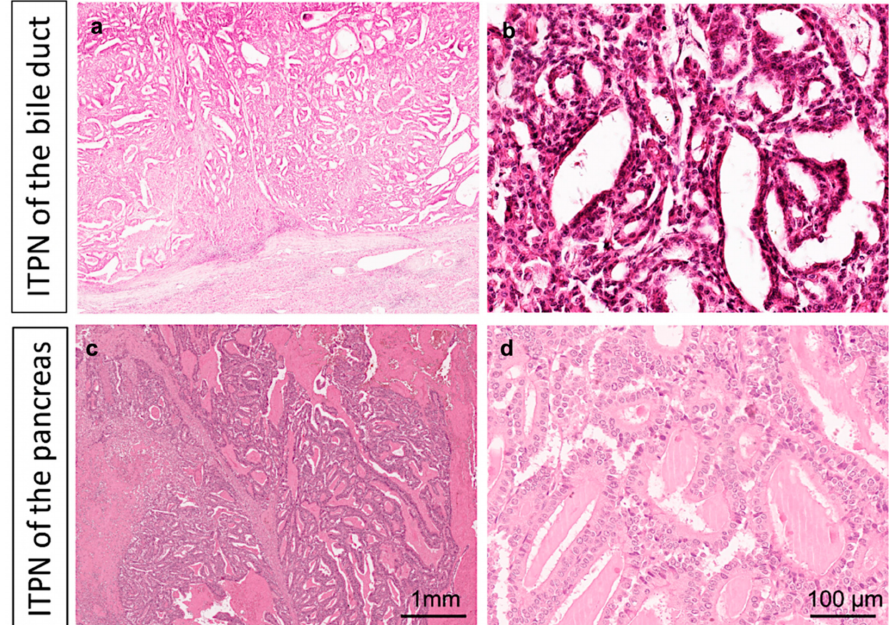
Figure 1. Histopathological hallmarks of intraductal tubulopapillary neoplasms (ITPNs). ITPNs of the bile duct ( a , b ) and pancreas ( c , d ) are characterized by intraductal tumor masses with predom- inant tubular growth in ITPN. Representative H&E staining at low (2 × , a , c ) and high (20 × , b , d ) magnification. Detailed clinical and histopathological information, as well as follow-up data of the study cohort, are given in Table